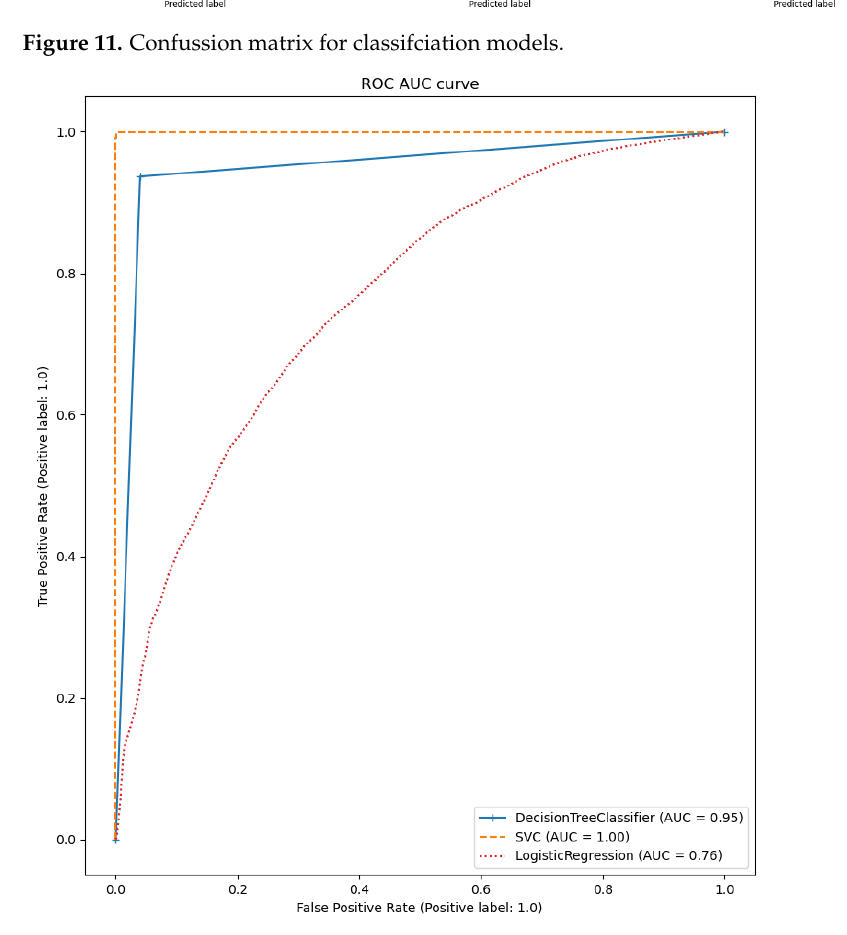
Figure 12. ROC-AUC plot for classification models. Table 5. Accuracy of evaluated regression models. Optimized hyperparameters are in brackets.